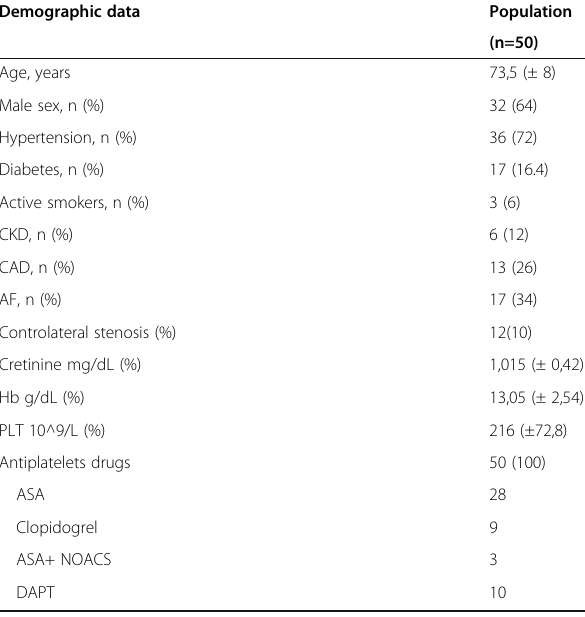
Table 1 (abstract A68). See text for